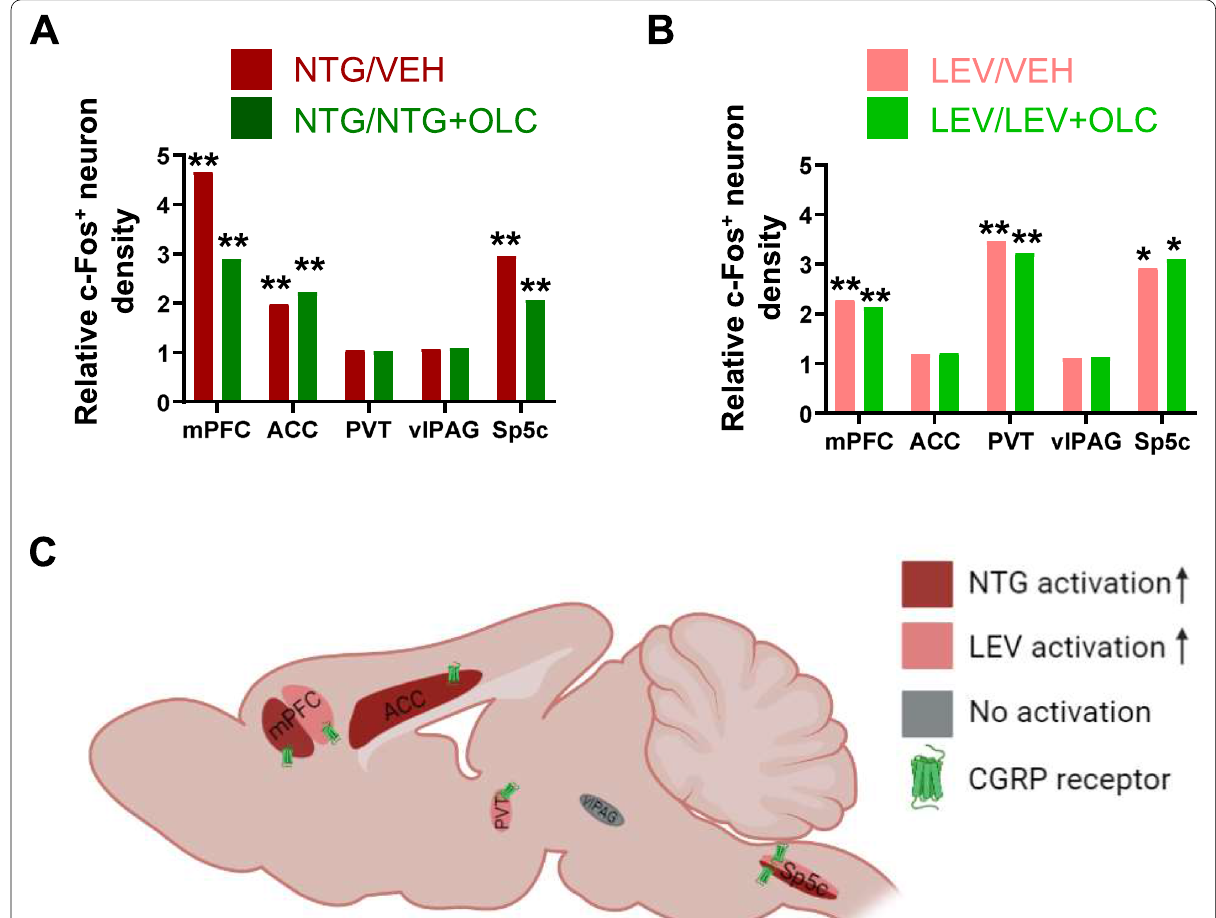
Fig.9 Brain activation in chronic migraine models. A‑B . The relative c-Fos + neuron density in several brain regions (A, red) and the relative c-Fos + neuron density with OLC treatment (B, green) in the NTG-induced chronic migraine model or LEV-induced chronic migraine model. C. The brain activation and alteration of brain activation with OLC treatment in the NTG-induced chronic migraine model (dark red) and LEV-induced chronic migraine model (pink); No activation (gray); CGRP receptor (green); (Created with BioRender.com). Abbreviations: VEH, vehicle; NTG, nitroglycerin; LEV, levcromakalim; OLC, olcegepant; mPFC, medial prefrontal cortex; ACC, anterior cingulate cortex; PVT, paraventricular thalamic nucleus; vlPAG, ventrolateral periaqueductal gray; Sp5c, caudal part of the spinal trigeminal